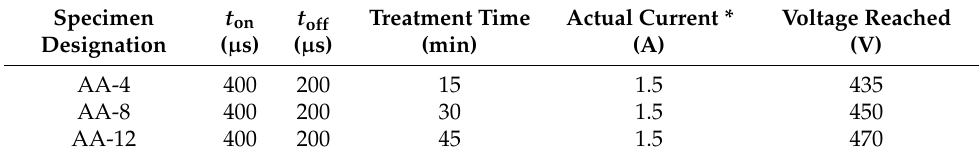
Table 2. Plasma electrolytic oxidation (PEO) process parameters and specimen